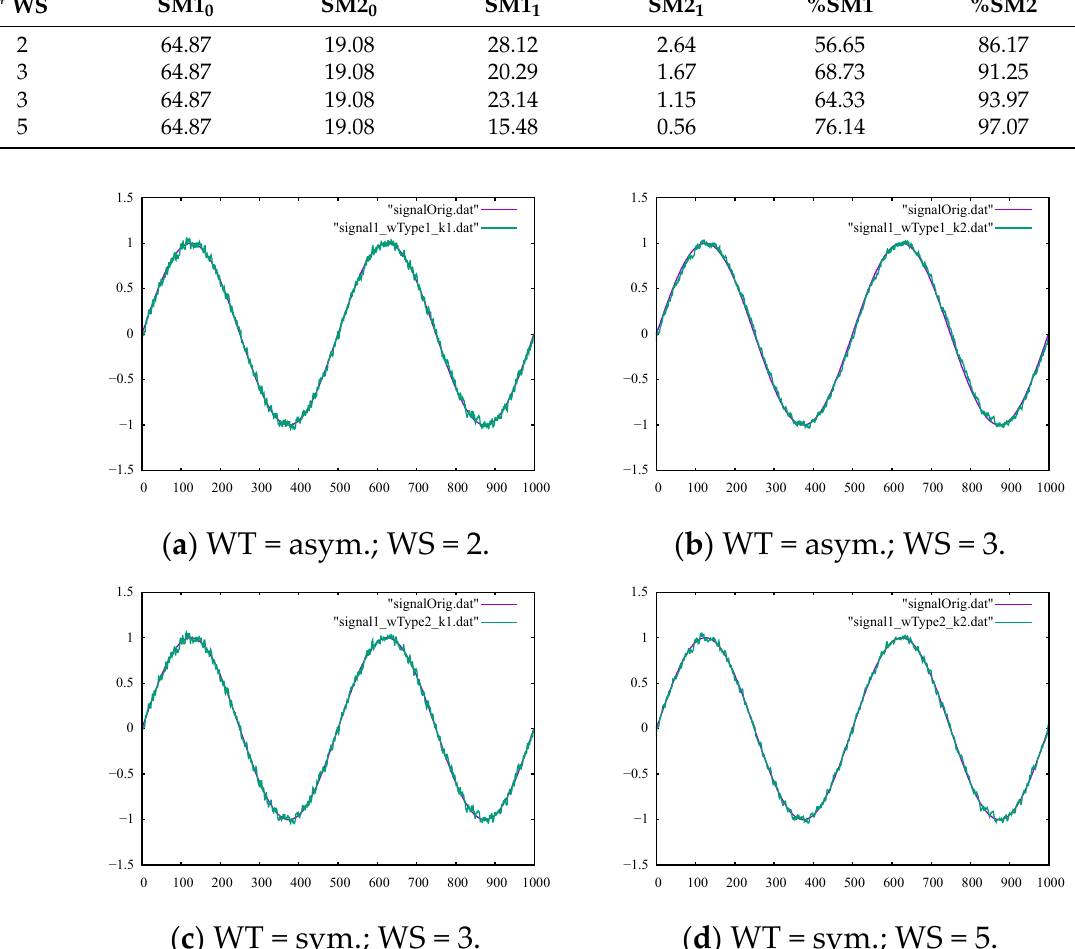
Table 2. Performance metrics of the B-spline smoothing method for different numbers of control points for approximation. The definitions of the symbols used are provided in the corresponding explanations for Equations (9)–(11). * No. CP: number of control points.